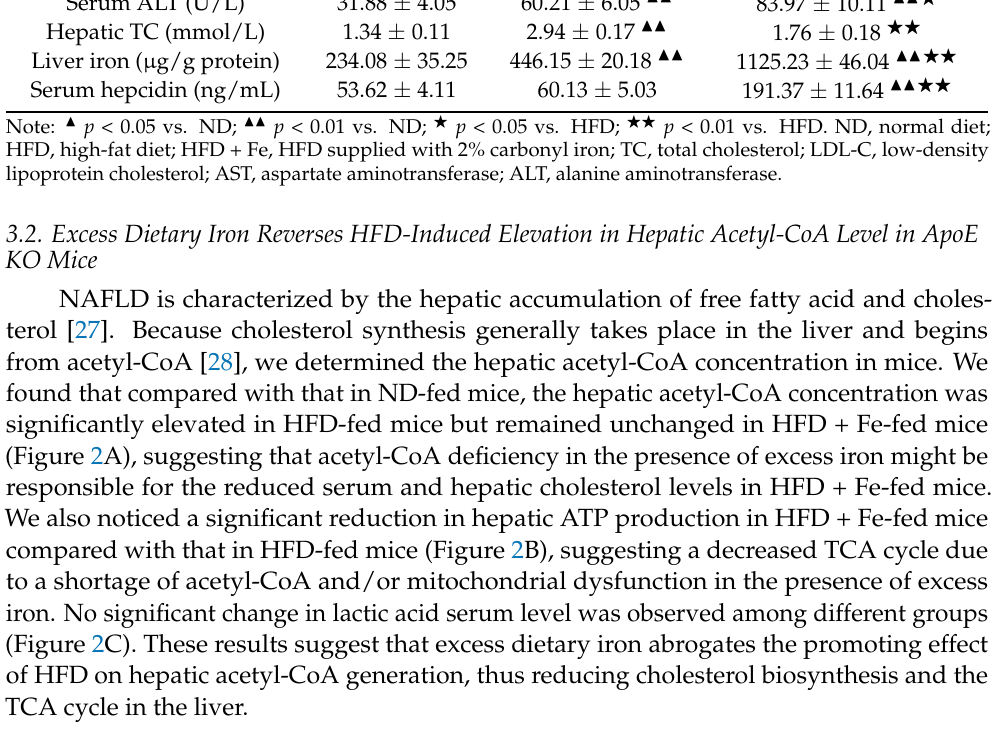
Table 2. Effect of dietary iron overload on biochemical parameters in ApoE KO mice ( n = 8). Groups Parameters ND HFD HFD + Fe Serum iron (mg/L) 193.55 ±